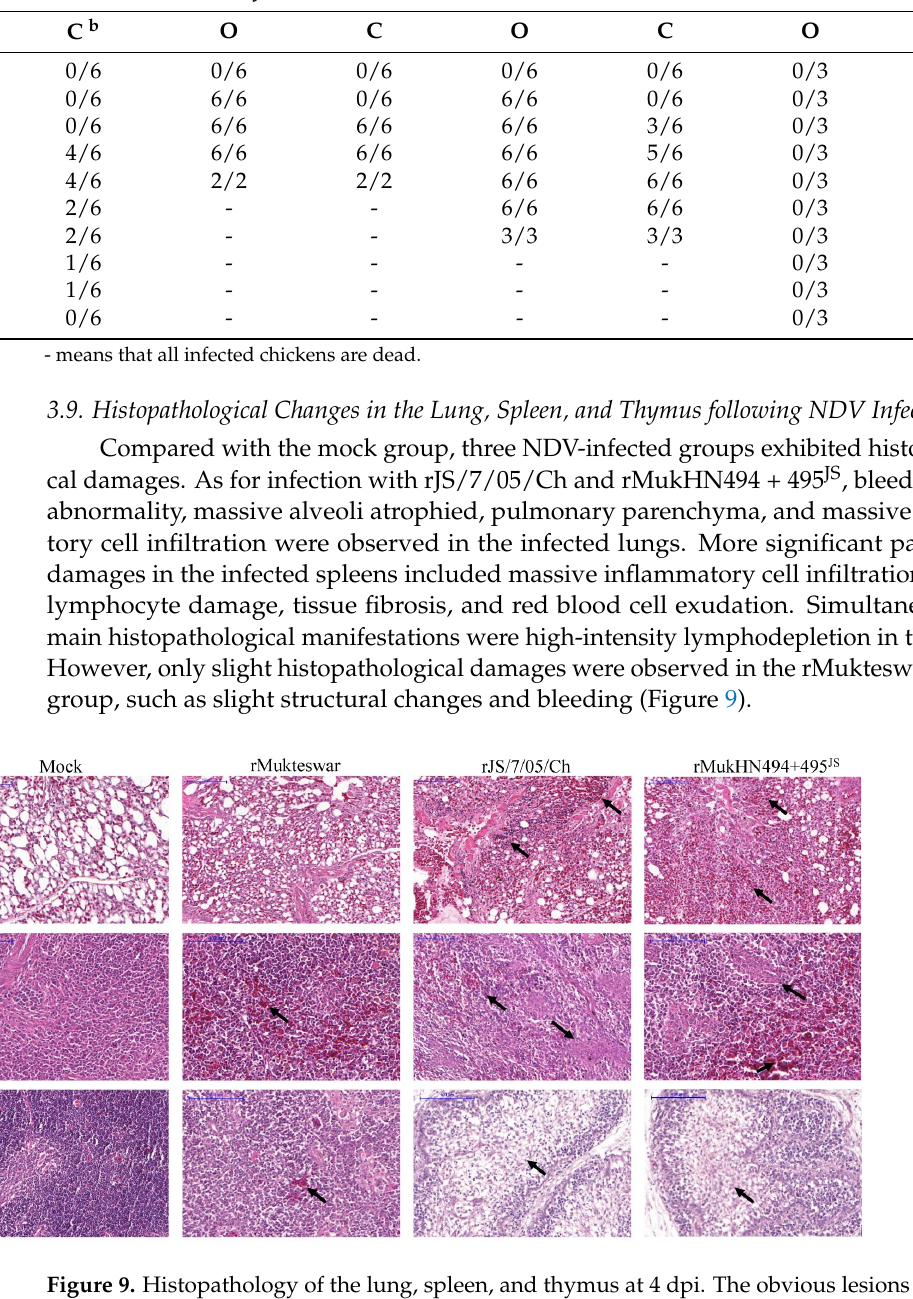
Figure 9. Histopathology of the lung, spleen, and thymus at 4 dpi. The obvious lesions are marked with black arrows. Magnification 200×, scale bar 100 μ m.